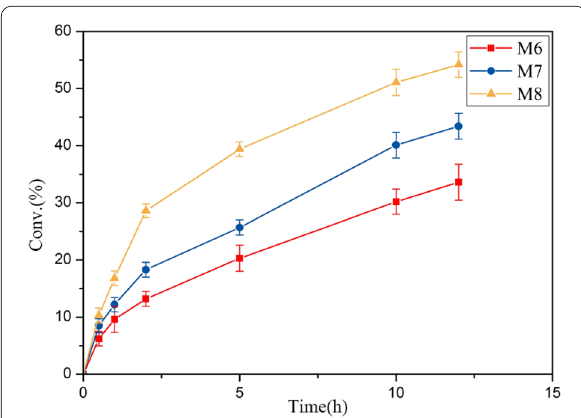
Fig. 5 Progress curves of caffeic acid catalyzed by the purified enzymes of three Ec MAL variants (M6, M7, M8). The enzymatic amination addition of caffeic acid (10 mM) was performed at 30 °C and pH 8.5 with a dose of each 0.5 mg/mL purified enzymes under the same conditions